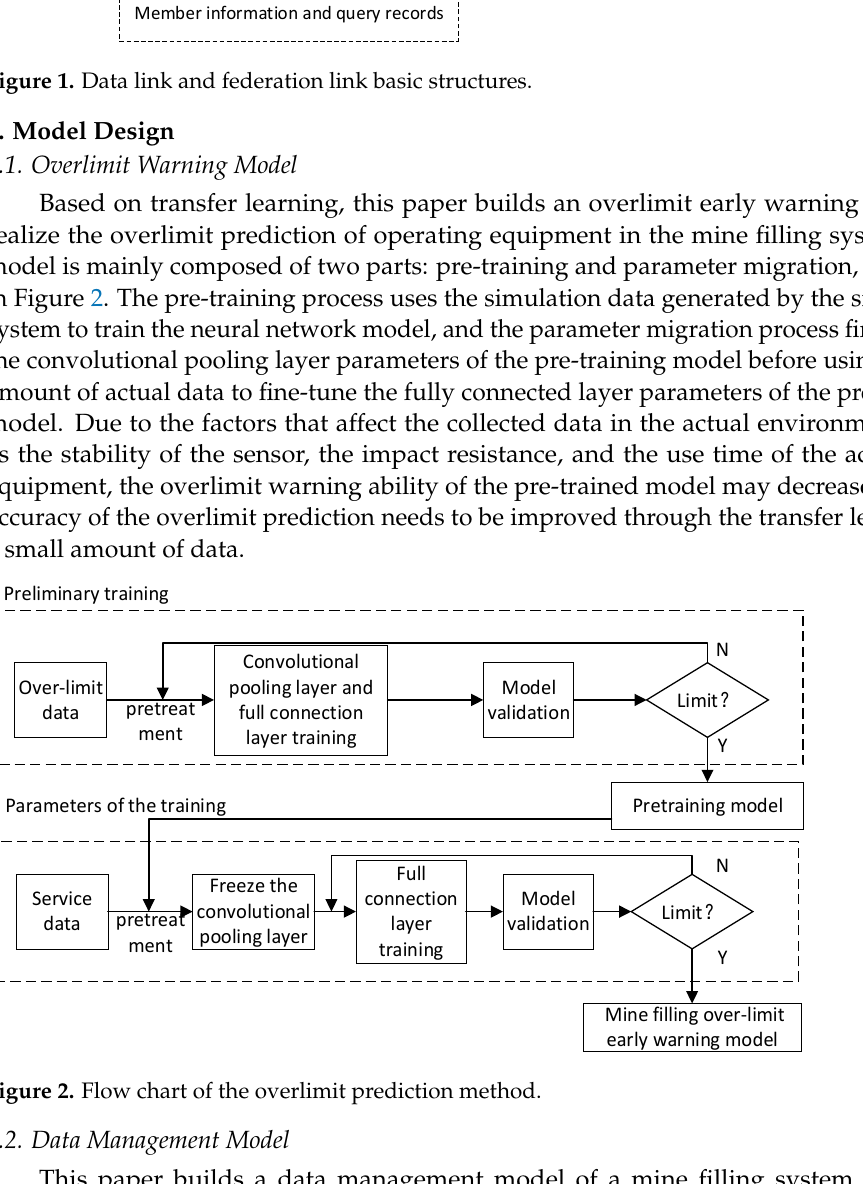
Figure 1. Data link and federation link basic structures.